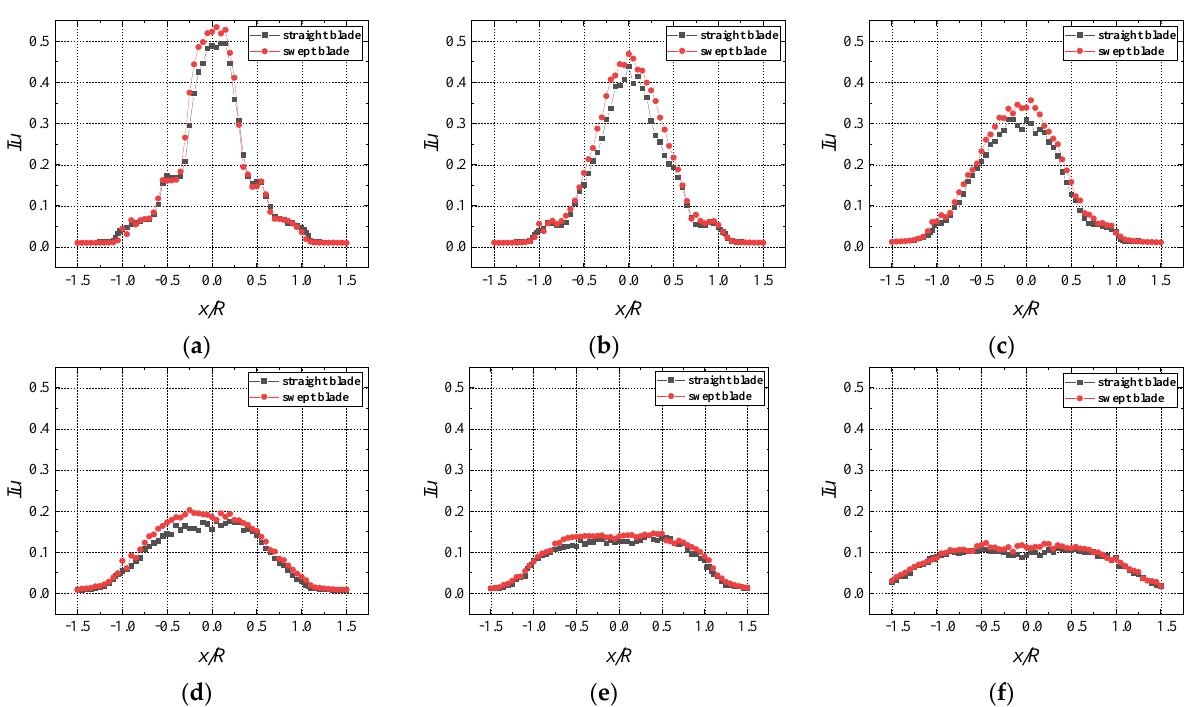
Figure 14. Streamwise turbulence intensity distribution at a yaw angle of 0° when λ = 4.67 . ( a ) 0.5D; ( b ) 1D; ( c ) 2D; ( d ) 3D; ( e ) 5D; ( f ) 8D.